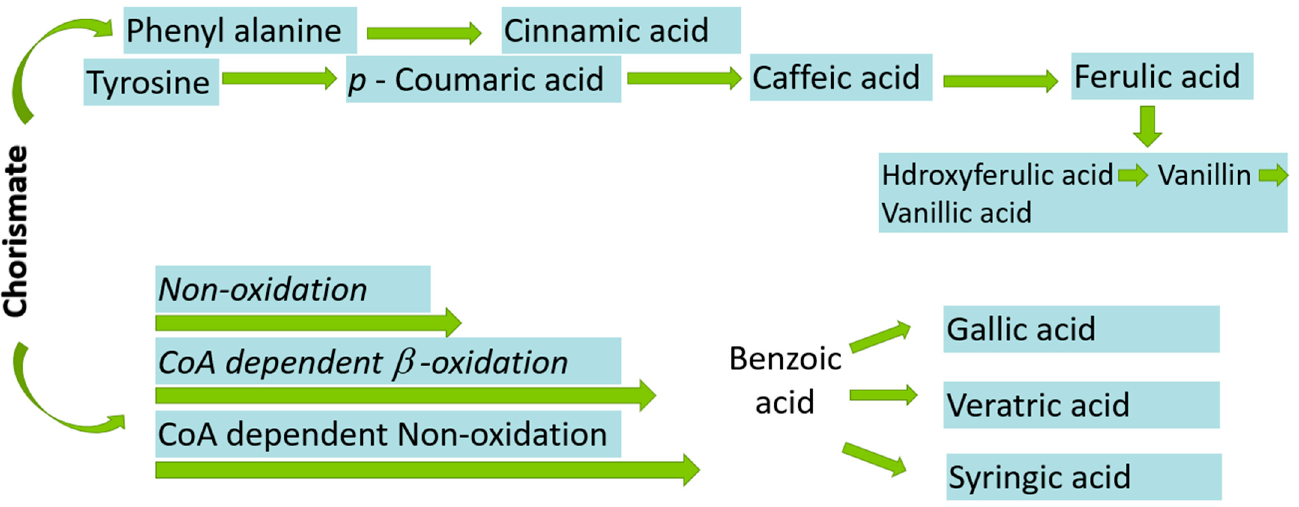
Figure 5. Biosynthesis of phenolic acids from chorismate.